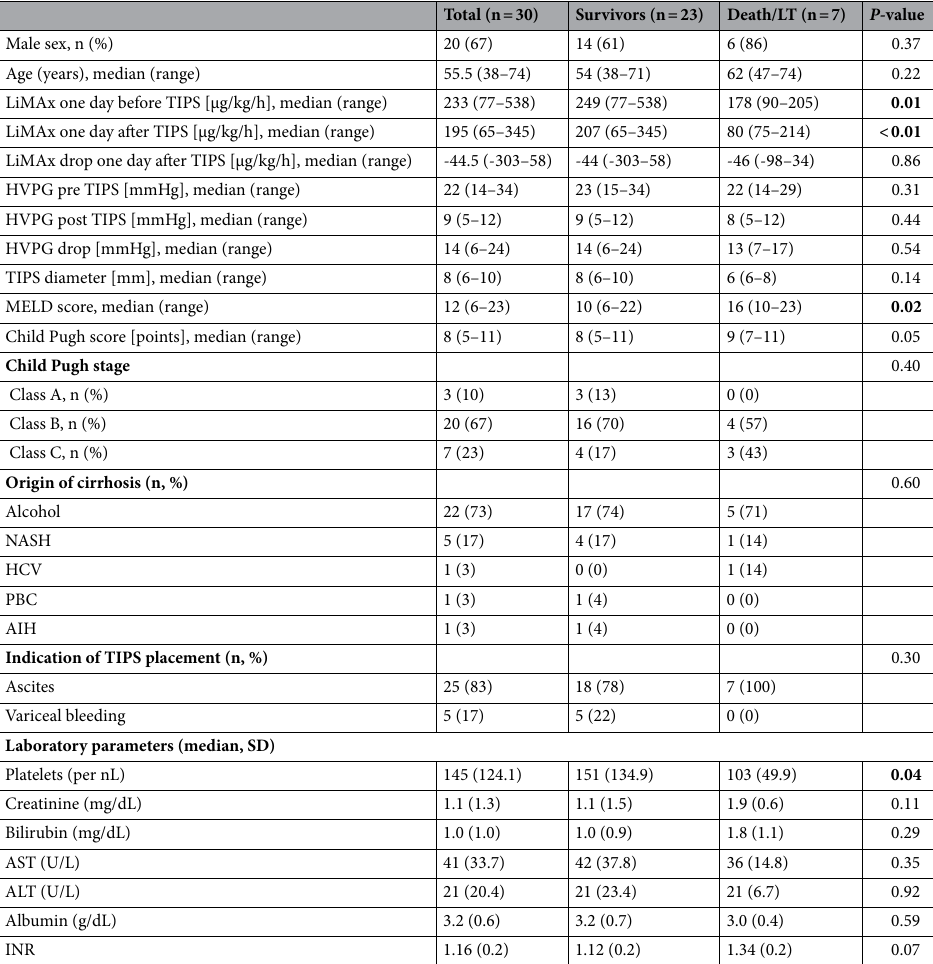
HVPG hepatic venous pressure gradient, INR international normalized ratio, MELD model for end-stage liver disease, NASH non-alcoholic steatohepatitis, PBC primary biliary cholangitis, TIPS transjugular intrahepatic portosystemic